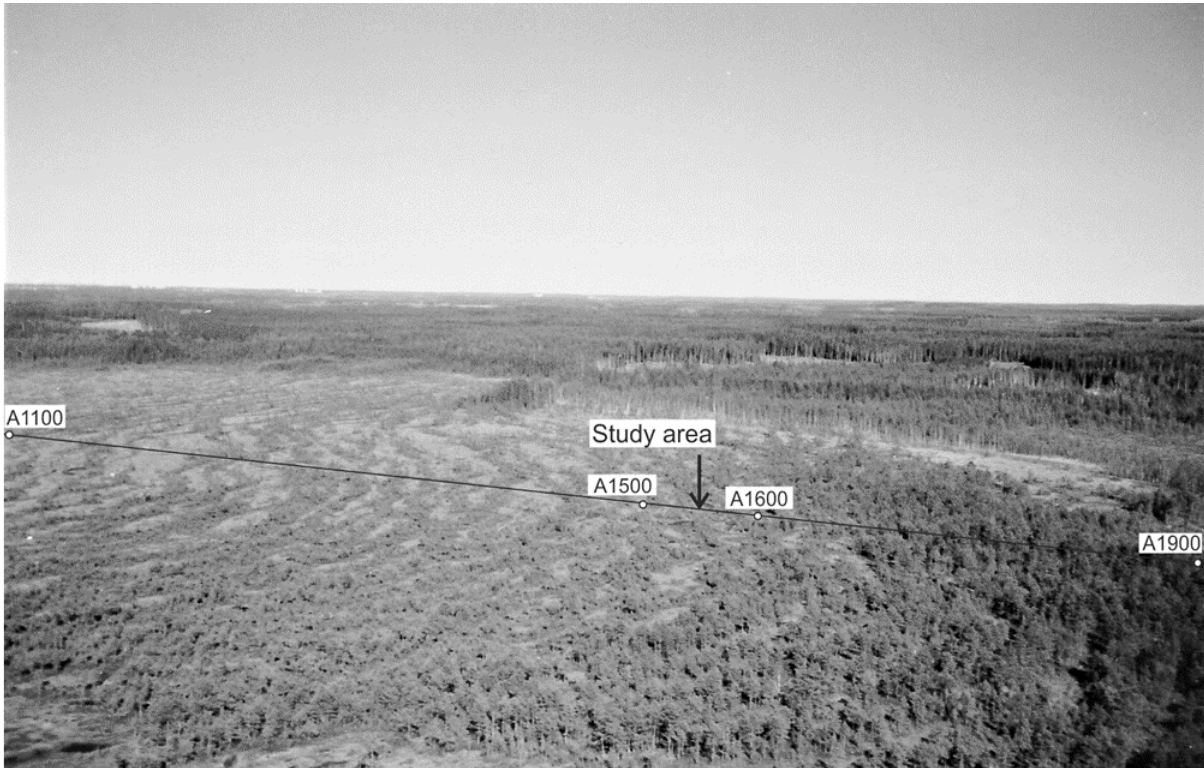
Figure 1. Oblique aerial photograph of the southern and central part of Haukkasuo showing the concentric pattern of hummocks and hollows. The arrow indicates the location of the study area on the main transect (see also Figure 2a). Photo: Rami Immonen (The Finnish Defence Forces)